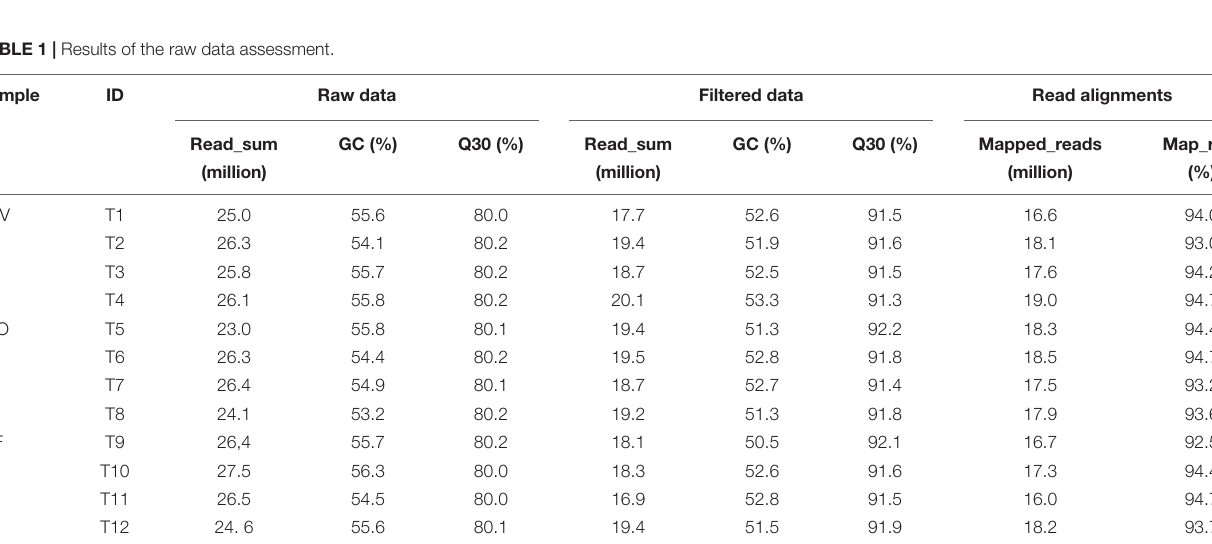
FIGURE 2 | Incubation of the experimental material. (A) Switchgrass plants used in this research. (B) Immature inflorescences used for incubation. (C) Explant cultured on SIM medium for 20 days. (D) Explant cultured on MS medium for 20 days. (E) Explant cultured on SIM medium for 30 days. (F) Explant cultured on MS medium for 30 days. (G) Explant cultured on SIM medium for 60 days. (H) Explant cultured on MS medium for 60 days. Bars = 1 cm.